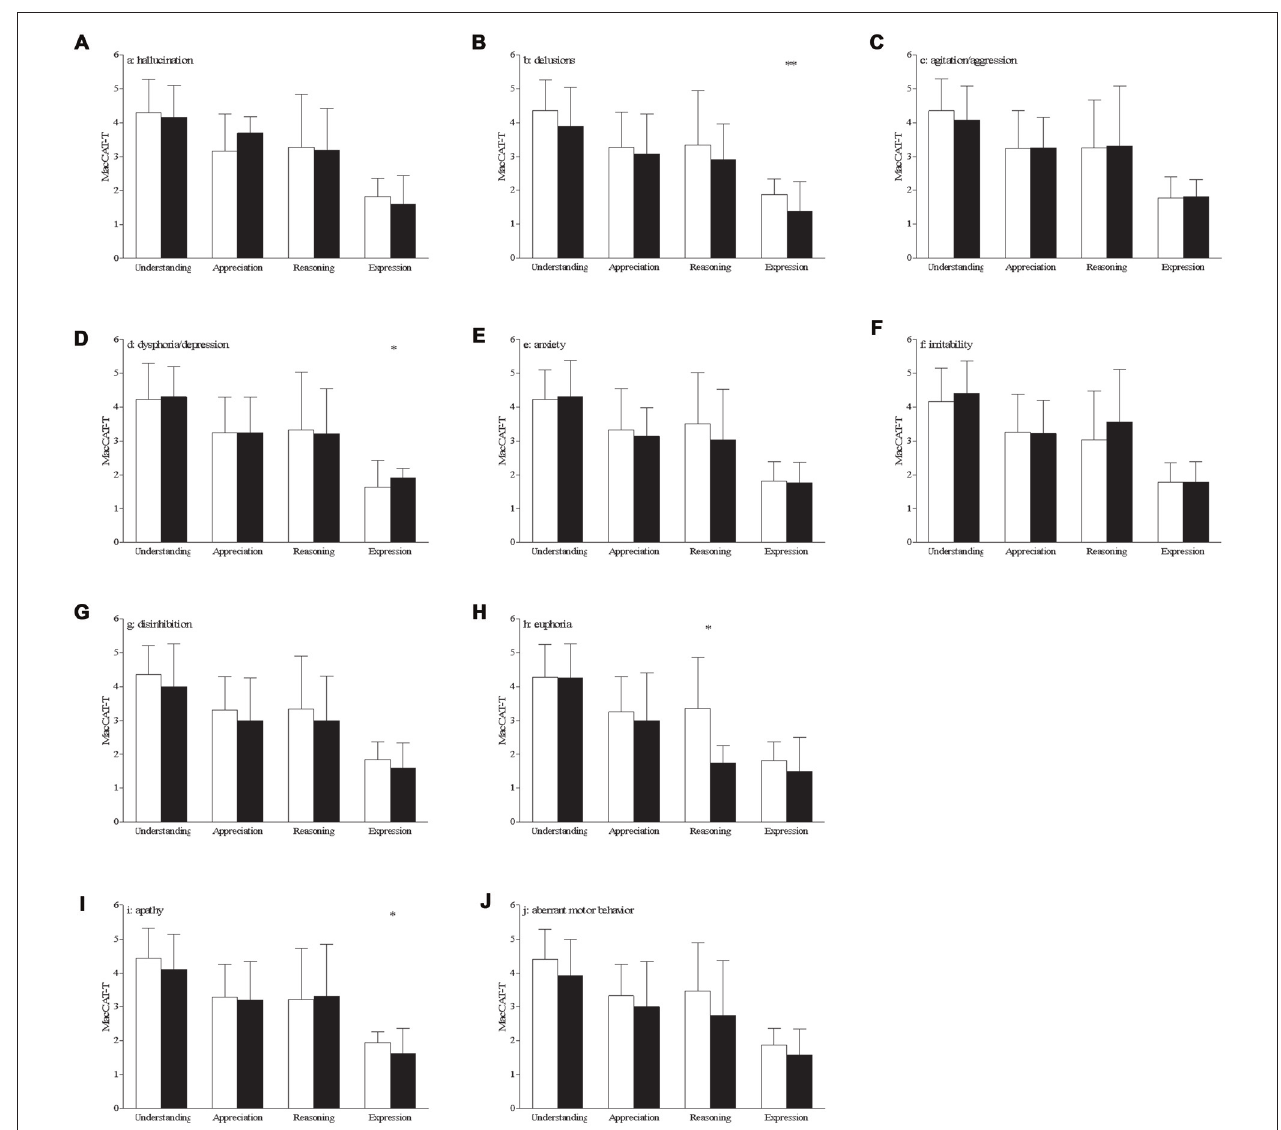
FIGURE 1 | Differences on MacArthur Competence Tool for Treatment (MacCAT-T) subscales according to the presence of behavioral and psychological symptoms of dementia (BPSD; A–J ) bar graph of the mean with standard deviation of the MacCAT-T subscales per subscale of the neuropsychiatric inventory (NPI). White bars represent the patients with a score of 0 on that domain, black bars those patients with a score of 1 or higher on that domain; ∗ p < 0.05, ∗∗ p < 0.01; significant differences can be seen for delusions, dysphoria and apathy (expression of choice) and for euphoria